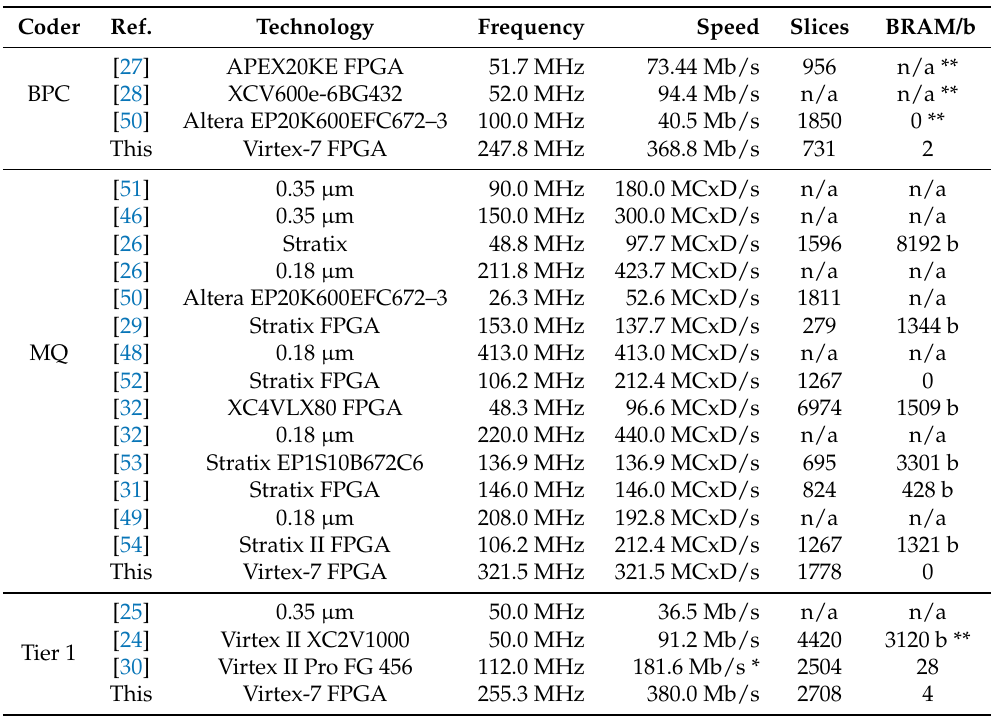
Table 2. Comparison with other implementations.